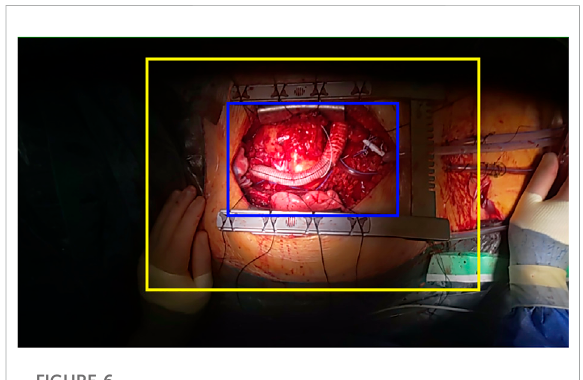
FIGURE 6 Corresponding RGB frame. The high dynamic range for correctly exposing bright parts of the situs results in partly almost black surroundings. The situs is highlighted in blue border.